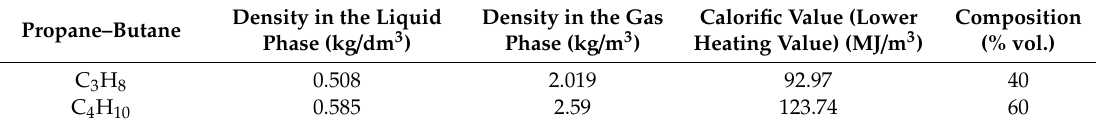
Table 2. Composition and properties of propane–butane gas (PBG).